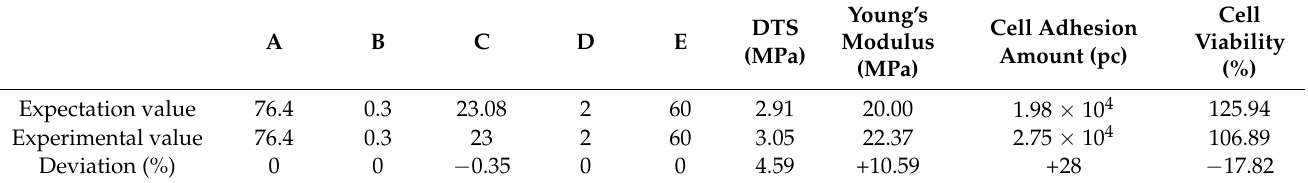
Table 9. Optimization parameter verification.